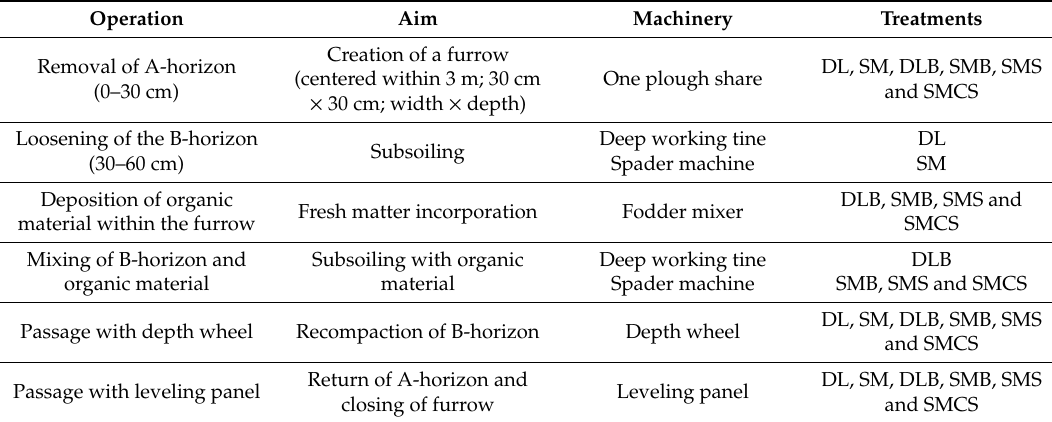
Table 1. Overview of tillage operations for subsoiling with and without organic material. DL: deep loosening with tine, SM: spader machine, DLB: deep loosening with tine and bio compost, SMB: spader machine and bio compost, SMS: spader machine and sawdust, SMCS: spader machine and chopped